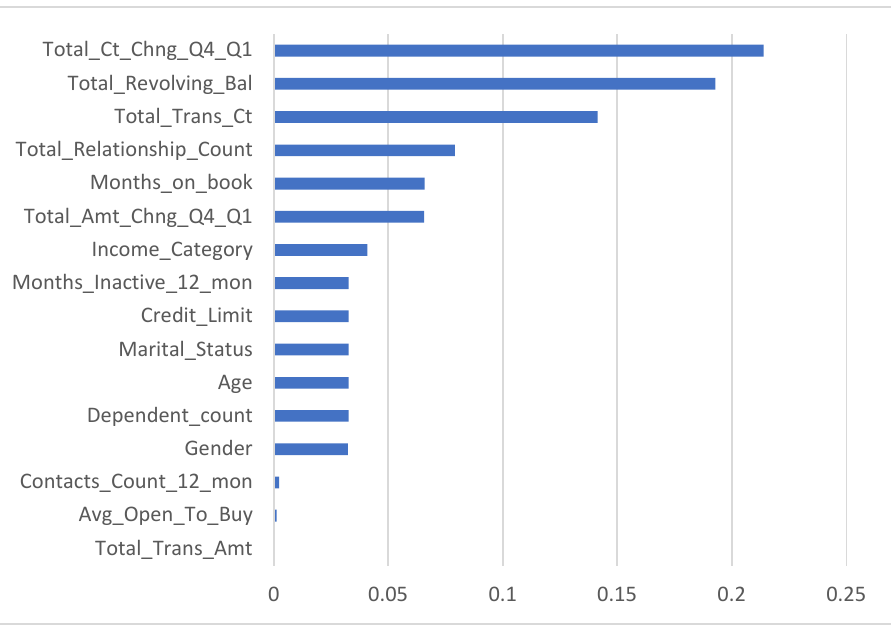
Figure 2. The importance of variables for Model 1 after applying C5 tree model.